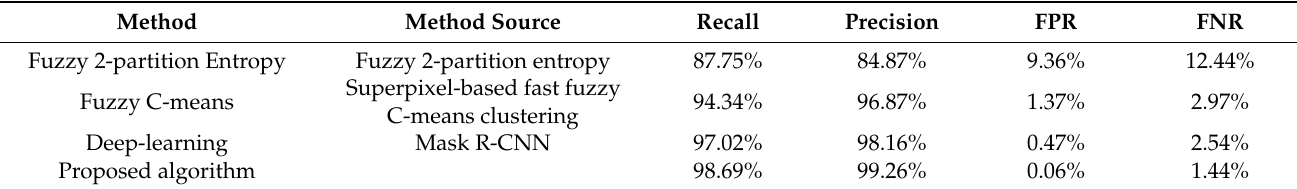
Figure 7. Computational efficiency of different methods; comparison between fuzzy 2-partition entropy, SFFCM, mask R-CNN, and the proposed algorithm.